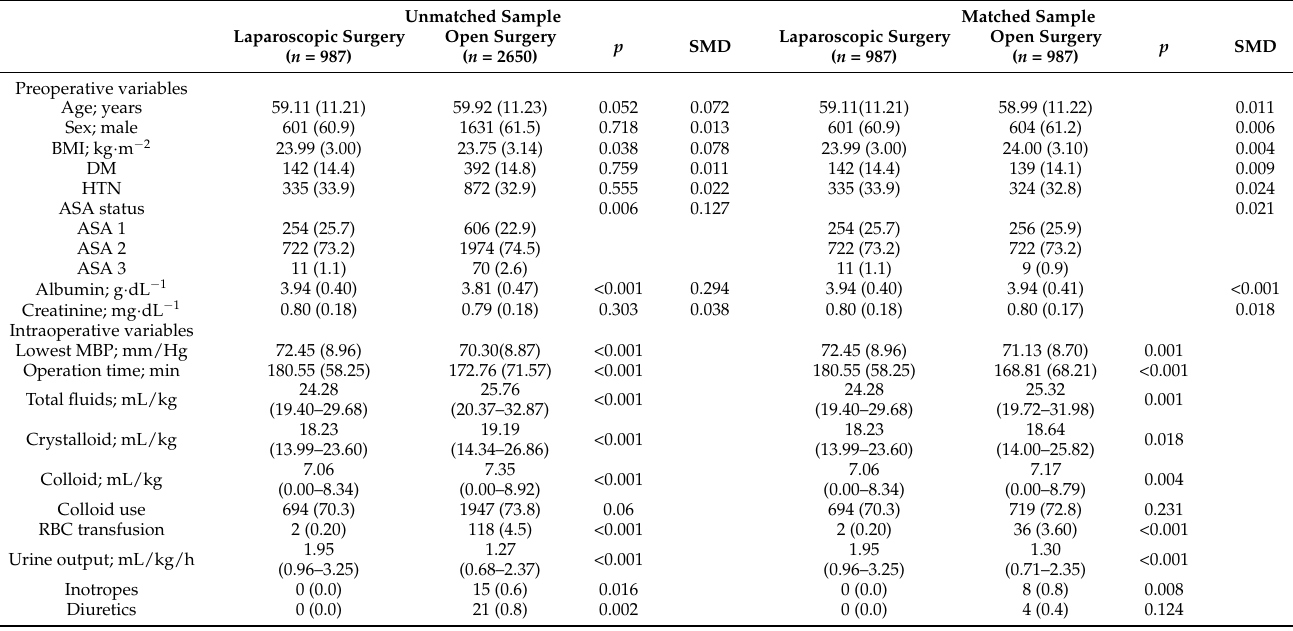
Table 1. Baseline characteristics of the study populations in the unmatched and matched samples. Unmatched Sample Matched Sample Laparoscopic